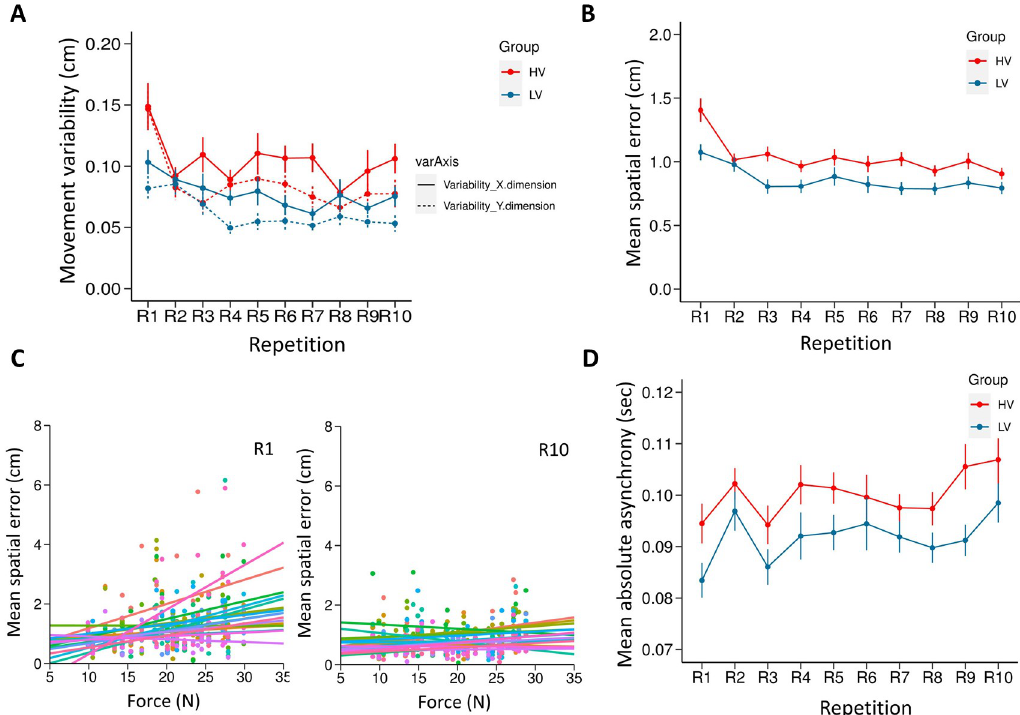
Fig 5. Results of Experiment 1. (A) Normalized variability of participant’s movement in the horizontal and vertical dimension. (B) Spatial error as a measure of individual performance. The spatial error at each repetition is an average of all 8 configurations from each of the 8 blocks. (C) Repeated measures correlation analysis between the force perturbation experienced and the spatial error of the participants in the HV group, for R1 and R10 separately. Each participant’s data and corresponding rmcorr fit lines are shown in different colors. (D) Absolute Asynchronies as a measure of joint performance. All error bars display standard error of